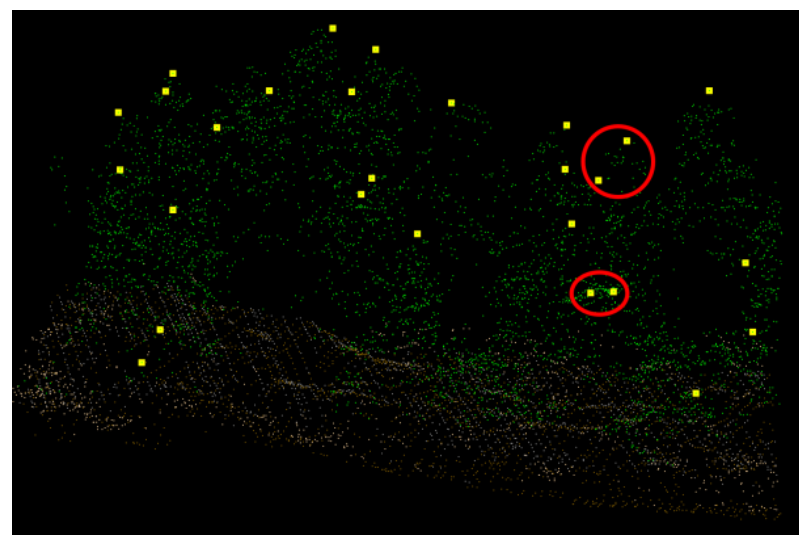
Figure 5. The tree locations in the red circles each belong to one tree.